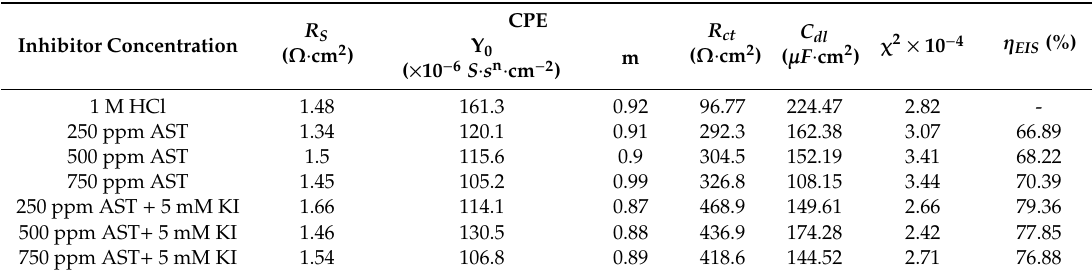
Table 4. Electrochemical kinetic parameters obtained from EIS data for C1018 carbon steel in 1 M HCl and various concentrations of AST and AST + KI at 25 ◦ C.